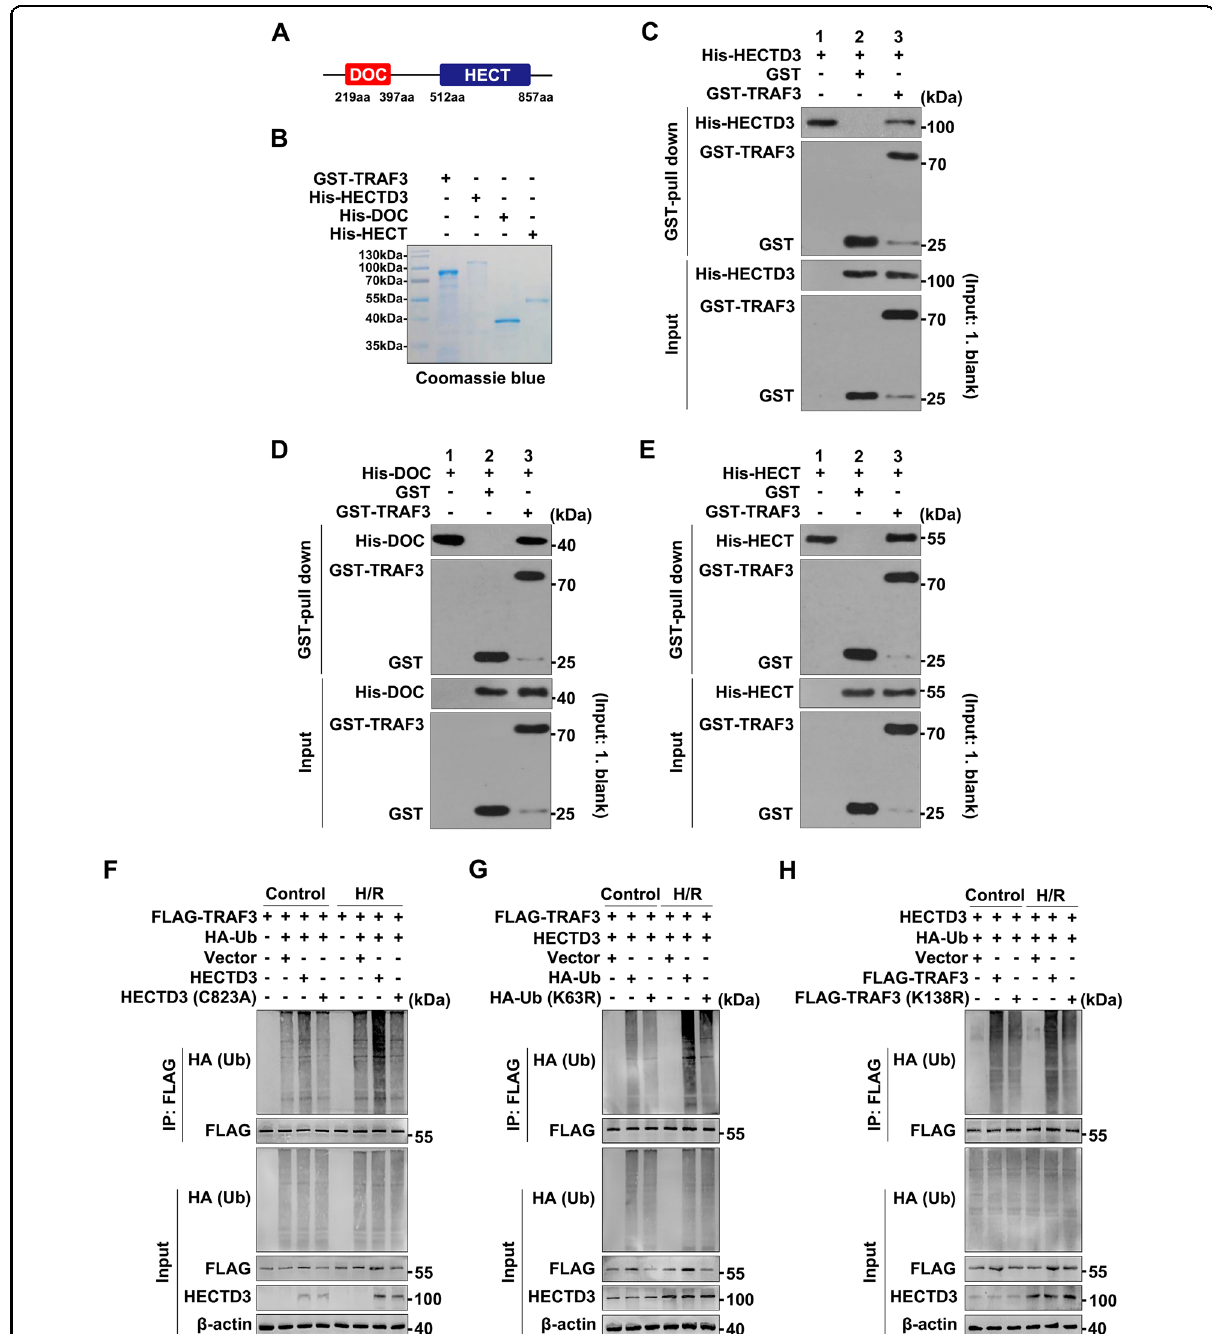
Fig. 6 Interaction between HECTD3 and TRAF3. A Schematic diagram of the domain architecture of HECTD3. The DOC domain is located at the amino acid (aa) sequence 219 to 397, whereas the HECT domain is located at the amino acid (aa) sequence 512 to 857. B Coomassie-stained SDS- PAGE of puri fi ed TRAF3 and recombinant HECTD3 constructs: GST-tagged TRAF3 and His-tagged full-length HECTD3, His-tagged isolated DOC and HECT domains. C – E GST pull-down assay with puri fi ed GST-TRAF3 and recombinant His-tagged full-length HECTD3, His-tagged isolated DOC and HECT domains. Puri fi ed GST-tagged TRAF3 was incubated with His-tagged full-length HECTD3 ( C ), the isolated DOC ( D ) and HECT domains ( E ). The interaction between TRAF3 and HECTD3, the DOC and HECT domains were visualized using immunoblots. F – H Ubiquitination analysis of TRAF3 and the interaction sites between HECTD3, Ub and TRAF3. BRL-3A cells transfected with mutants HECTD3 (C823A), HA-tagged Ub (K63R) and FLAG- tagged TRAF3 (K138R) plasmids or the corresponding WT and vector plasmids. Cellular protein extracts in BRL-3A cells with or without H/R were immunoprecipitated with primary antibody for FLAG. The immunoprecipitates were blotted with the relative